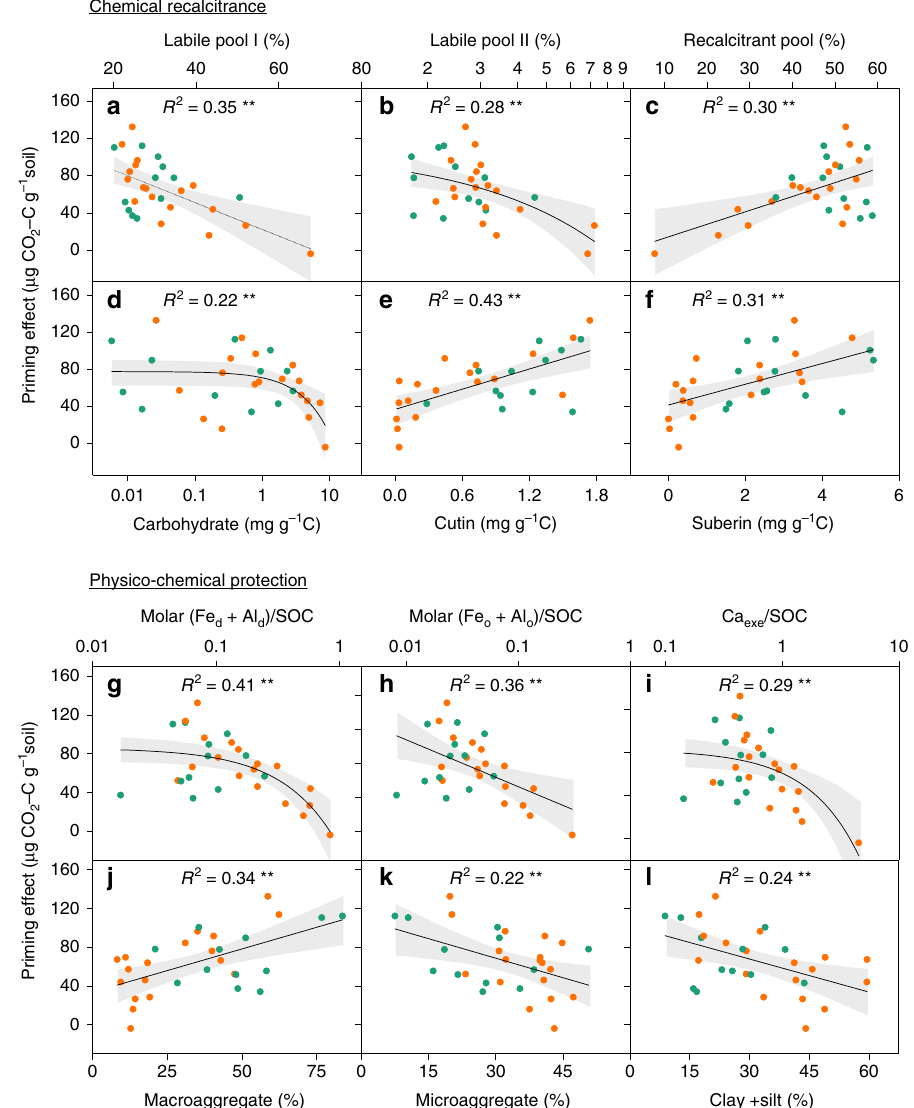
Fig. 1 Relationships of the priming effect with soil organic matter chemical recalcitrance and physico-chemical protection. Soil organic matter chemical recalcitrance is characterized by the proportion of labile pool I ( a ), labile pool II ( b ), the recalcitrant pool ( c ), relative abundances of carbohydrates ( d ), cutin-derived compounds ( e ) and suberin-derived compounds ( f ). Physico-chemical protection is re fl ected by the molar ratios of free Fe/Al oxides ( g ) and amorphous Fe/Al oxides ( h ) to SOC, the ratio of exchangeable Ca to SOC ( i ), and the SOC proportions in macroaggregates ( j ), microaggregates ( k ), and clay + silt fractions ( l ). The solid lines represent the fi tted ordinary least-squares model, and the grey areas correspond to 95% con fi dence intervals. A base-10 log scale is used for the x -axis of b , d and g – i . The orange dots and green squares represent data in alpine steppe and alpine meadow, respectively. **Signi fi cant correlation between the priming effect and the corresponding variables at the 0.01